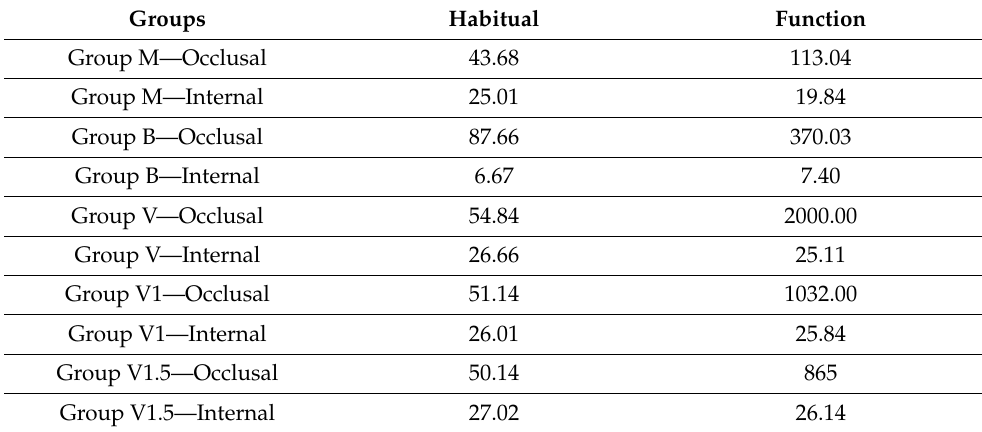
Figure 2. Distribution of the maximum principal stress in each group with habitual loading and simulating function with loading in the central fossa. Table 2. Maximum principal stress (MPa) in each group with habitual loading and simulating function with loading in the central